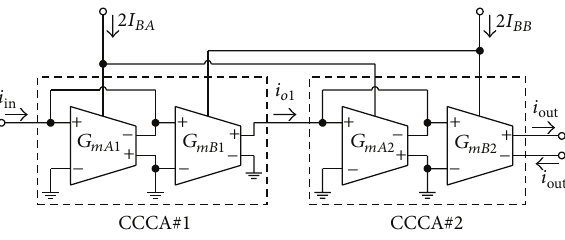
Figure 4: Linearly tunable current amplifier (LT-CA).